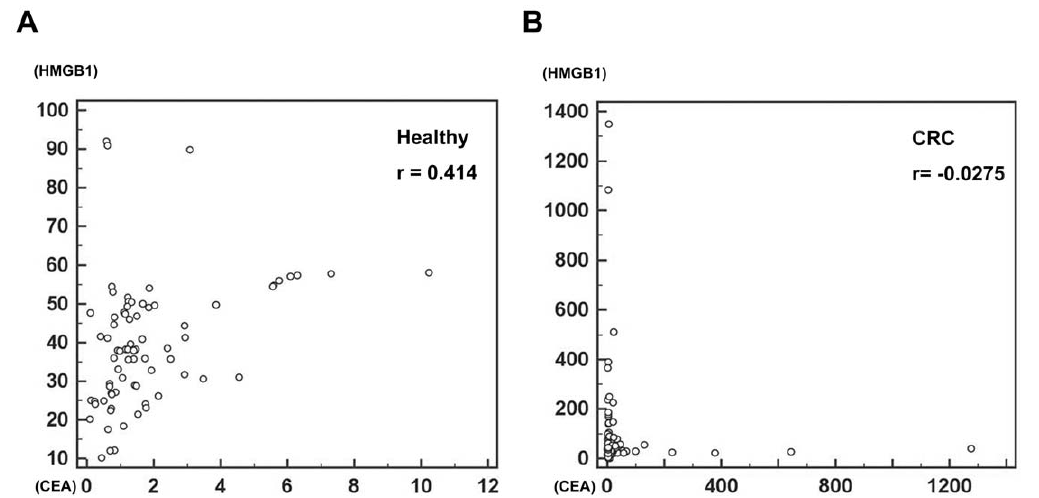
Figure 4. Correlation plot generated with serum CEA and HMGB1 levels. To assess the relationship between serum CEA and HMGB1 levels for the correlation, we used the Spearman’s rho method to determine the correlation coefficient r. (A) Correlation plot of 75 healthy subjects for CEA and HMGB1 serum expression levels. The correlation coefficient r was 0.414 (P=0.0002) for the two values in healthy control group showing these two markers were positively correlated with each other. The X axis represents CEA levels and the Y axis represents HMGB1 levels, respectively. (B) Correlation plot of 219 colorectal carcinoma patients for CEA and HMGB1 serum expression levels. The correlation coefficient r was 2 0.0275 (P=0.6858) for the two values in cancer patients demonstrating that these two markers seems to be negatively correlated with each other despite its low accuracy for this tendency. The X axis represents CEA levels and the Y axis represents HMGB1 levels, respectively.